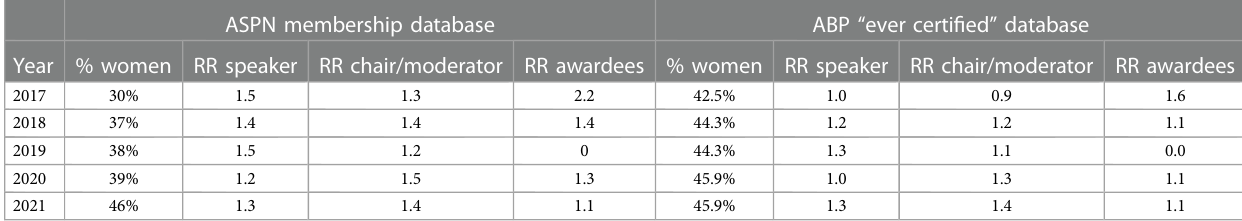
TABLE 1 Comparison of representation ratios (RR) using the ASPN membership database proportion of women pediatric nephrologists, compared to proportion of women pediatric nephrologists in the ABP ever certi fi ed database. ASPN membership database ABP “ ever certi fi ed ”